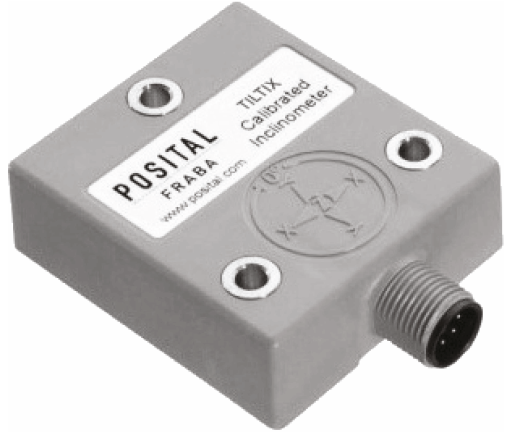
Figure 1: Inclinometer adopted in the